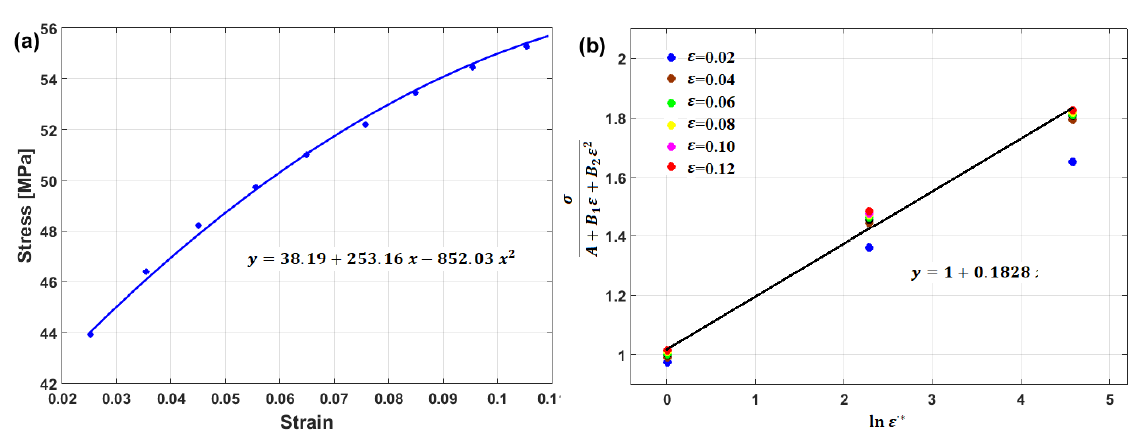
Figure 13. Determination of the modified JC model constants: ( a ) 𝐴, 𝐵 1 , and 𝐵 2 and ( b ) 𝐶 1 .